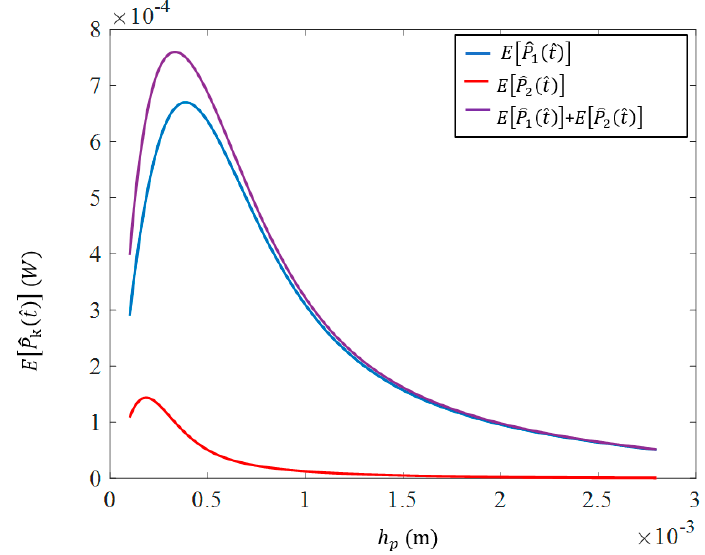
Figure 14. The electromechanical coupling factor of the thin beam, ϑ 2 , versus thickness of the piezoelectric layer.